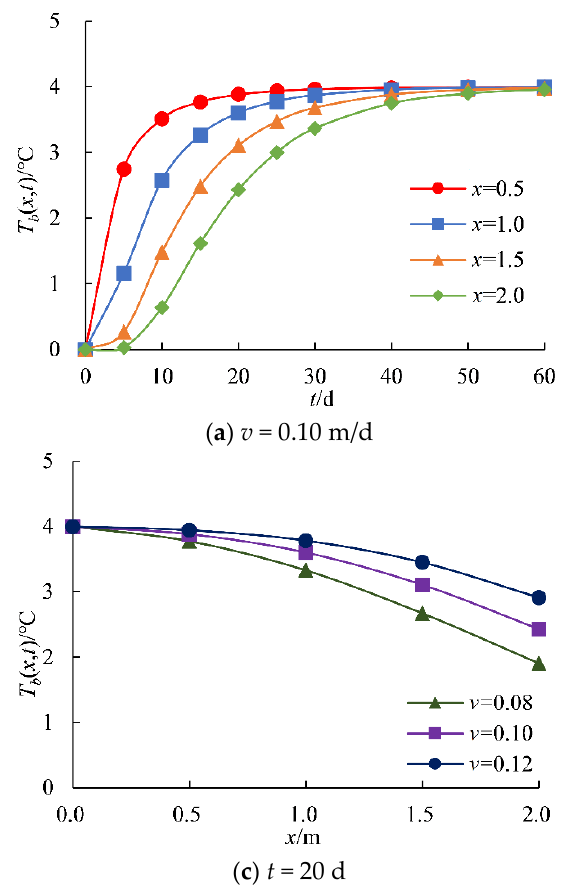
Figure 5. Variation curves of T b ( x , t ).